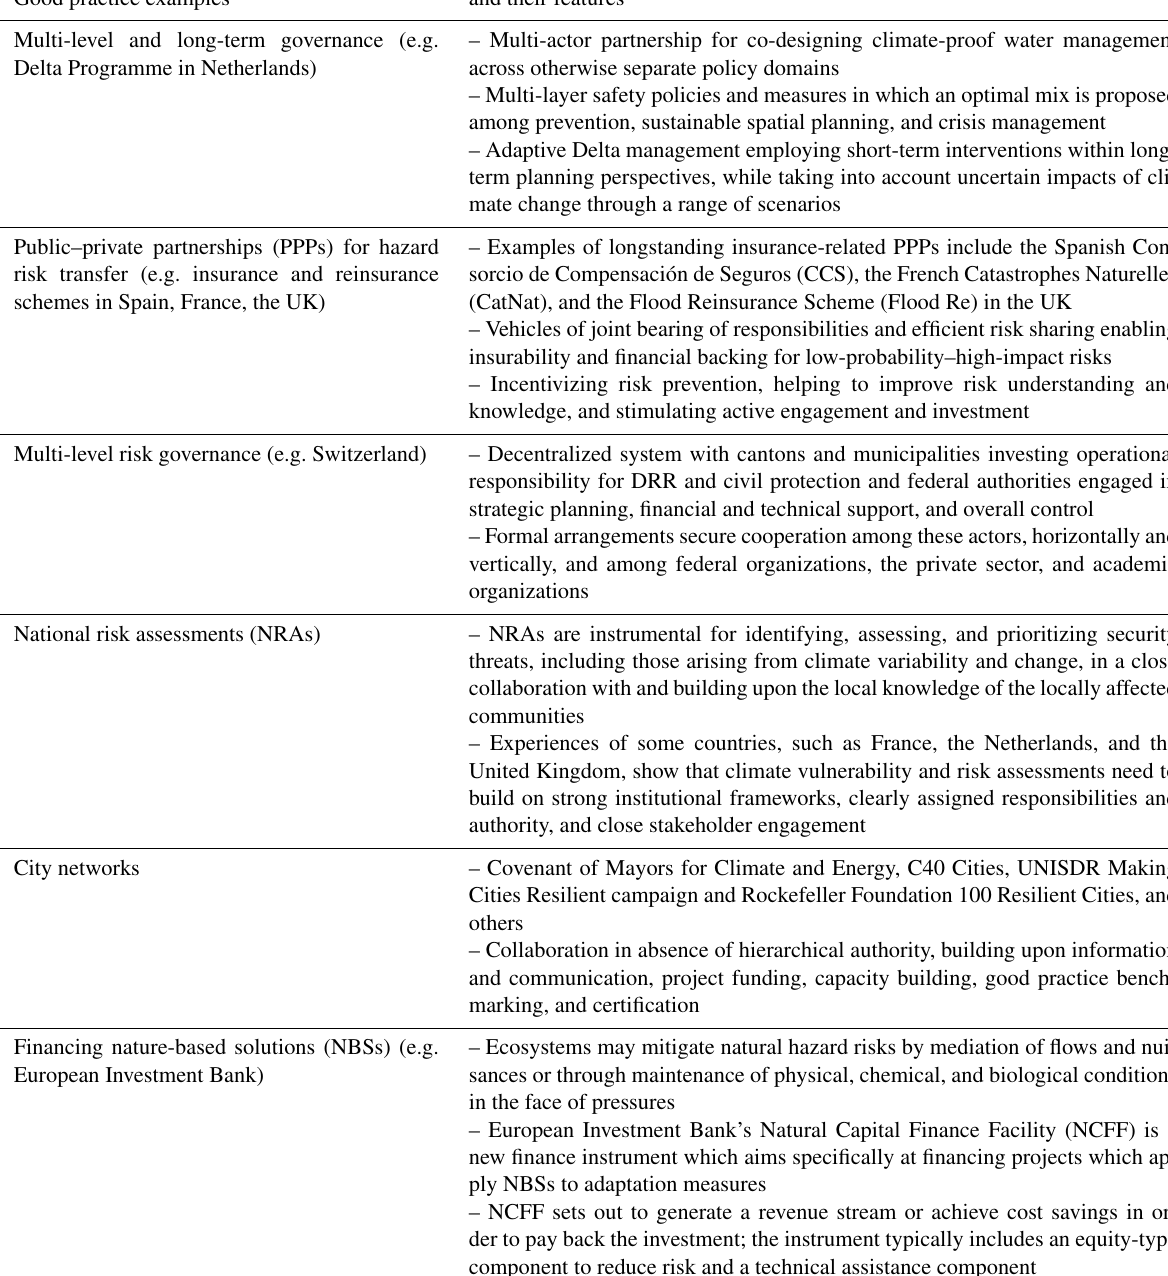
Table 1. Selected examples of good practice that fosters coherence between DRR and CCA. Good practice examples and their